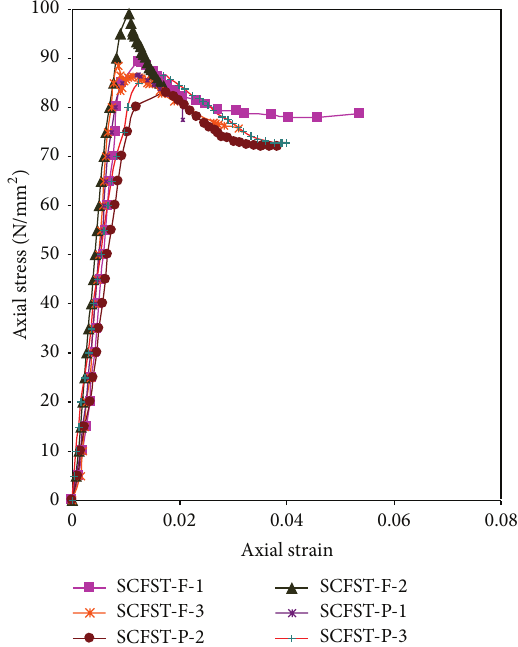
Figure 7: Axial stress-strain behavior of circular CFST column subjected to full and partial compression—comparison.